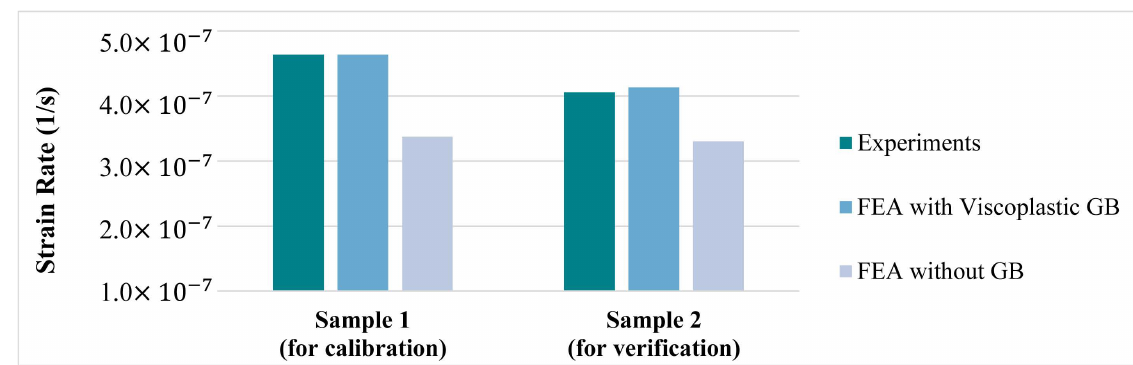
Figure 8. Comparison of experiments and simulations for TMM Samples 1 and 2.